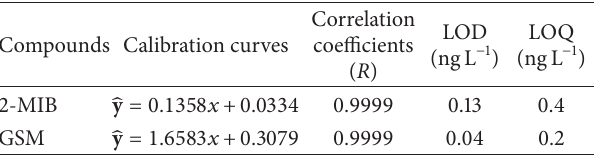
Table 7: The calibration curves and limits of detection for 2-MIB and GSM.